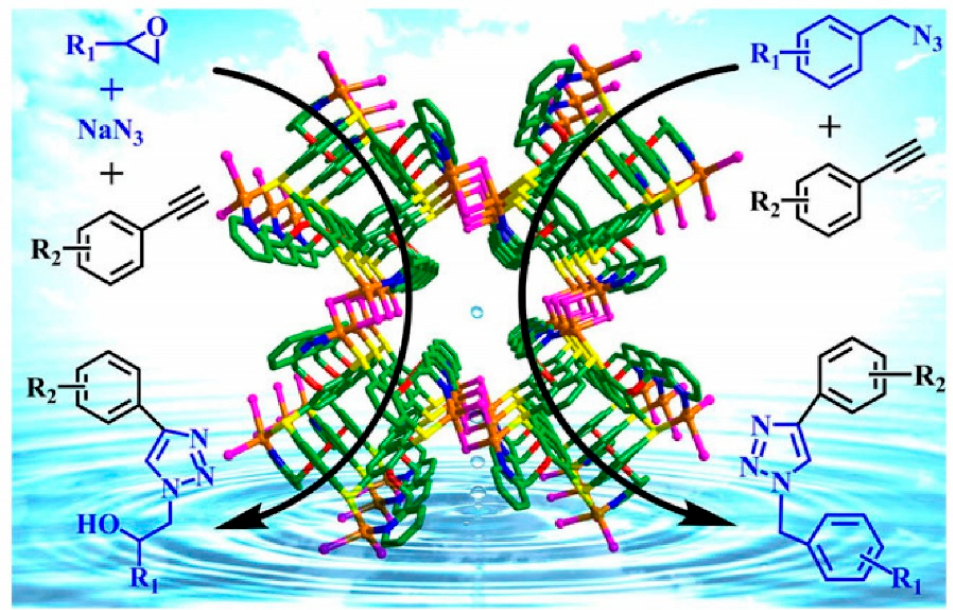
Figure 18. The metal–organic framework structures with exposed active CuI sites and a depiction of the catalytic activity for the formation of 1,2,3-triazole. Reproduced from [118] with permission from Wiley, copyright year: 2019.